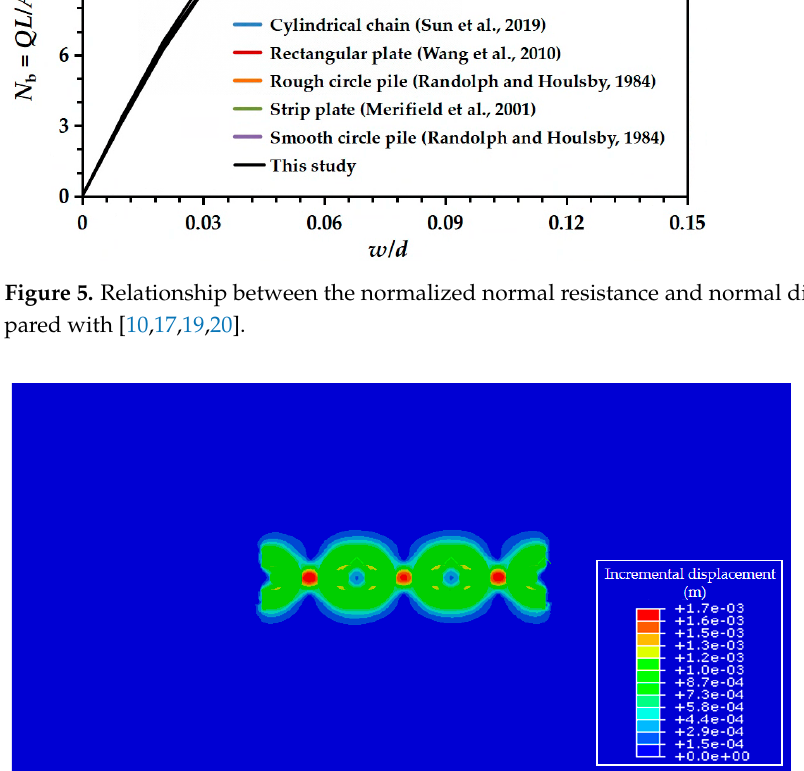
Figure 6. Incremental displacements of soil around the chain segment (referring to Figure